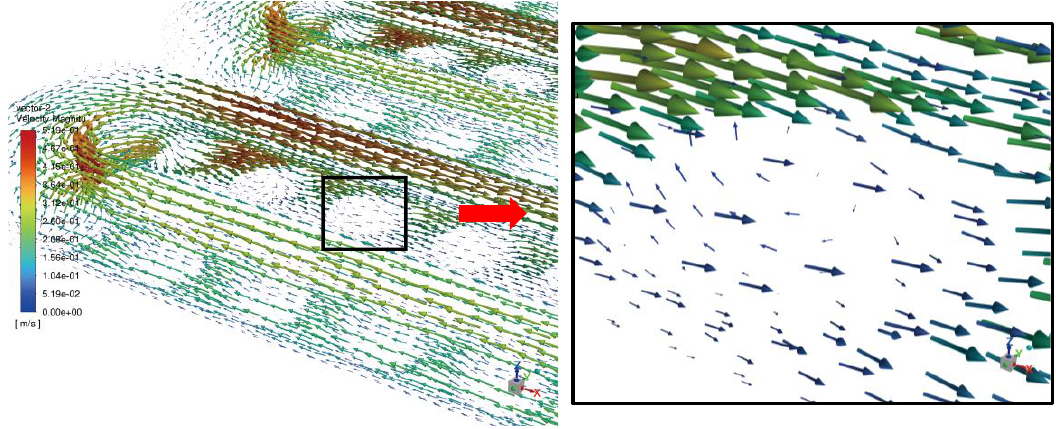
Figure 14 . Vector diagram of the “gear” return flow direction formed in the BFS structure.